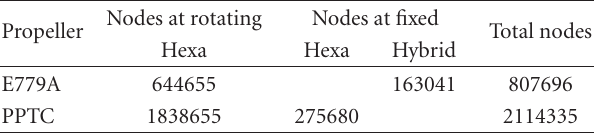
Table 3: Computational